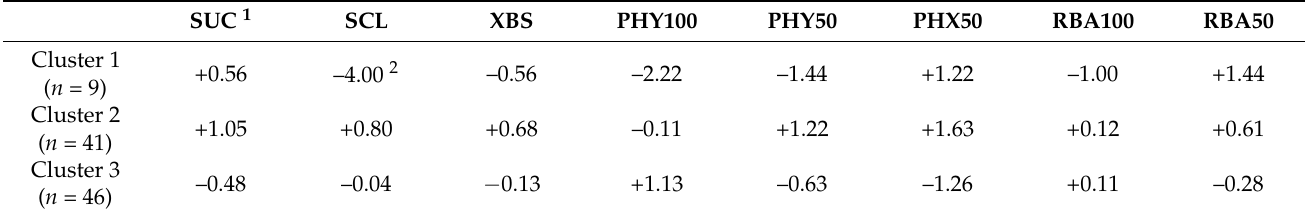
Table 8. Consumer segmentation according to acceptance shift with the provision of